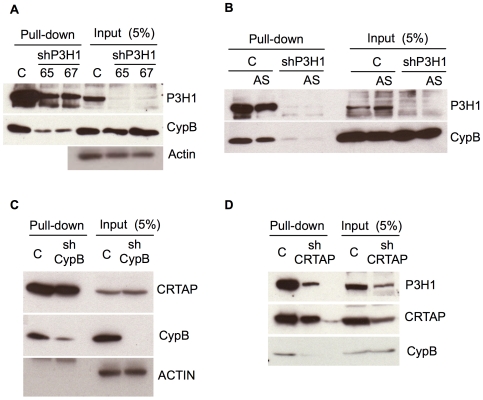
P3H1 and CRTAP are required for efficient binding of CypB to collagen in vitro.(A) Mouse fibroblasts were transduced with two different shRNA lentiviruses (#65 and #67) to knockdown P3H1 or a control lentivirus (“C”). Lysates were mixed with gelatin-sepharose to adsorb collagen binding proteins, and then recovered for western blotting, as indicated. Total cellular levels of CypB were not affected by knockdown of P3H1, however binding to gelatin was reduced. (B) As described in (A) in the absence or presence (“AS”) of ascorbic acid in the medium. (C) HeLa cells were transduced with a CypB specific shRNA lentivirus or control and lysates probed for gelatin-binding proteins as described. Knockdown of CypB did not affect CRTAP levels or binding to gelatin. (D) Knockdown of CRTAP in HeLa cells reduced P3H1 cellular levels and blocked the binding of CypB to gelatin in vitro.